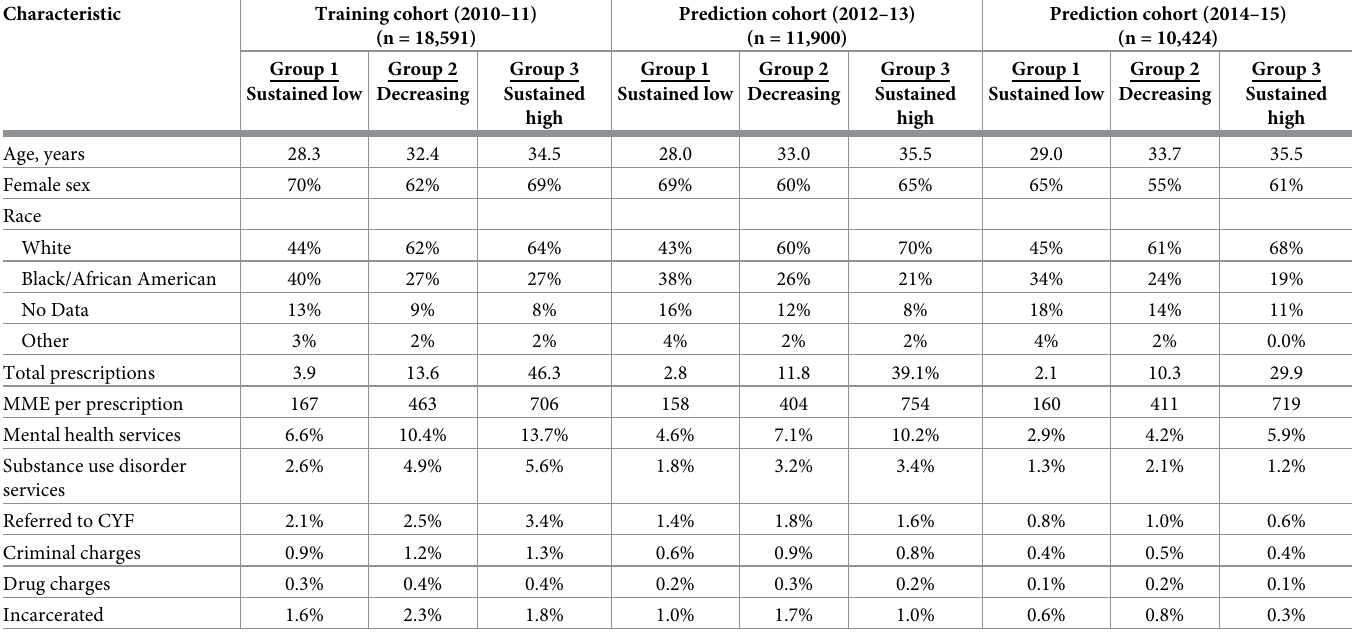
Table 3. Demographics, opioid prescription characteristics, and social outcomes stratified by cohort and trajectory group.